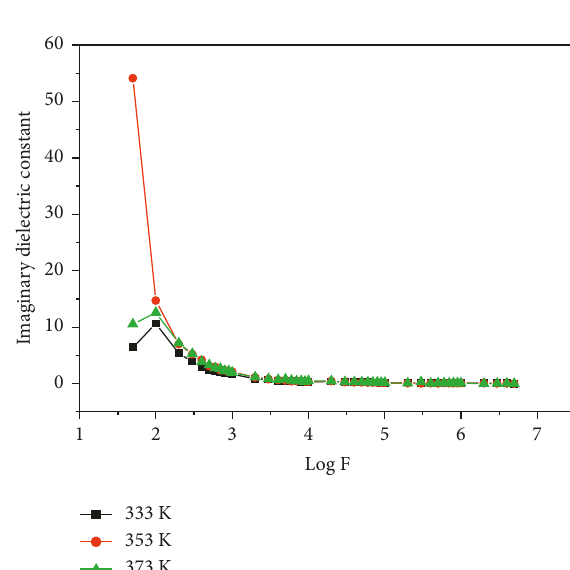
Figure 6: Imaginary dielectric constant ( ε ”) vs log F.